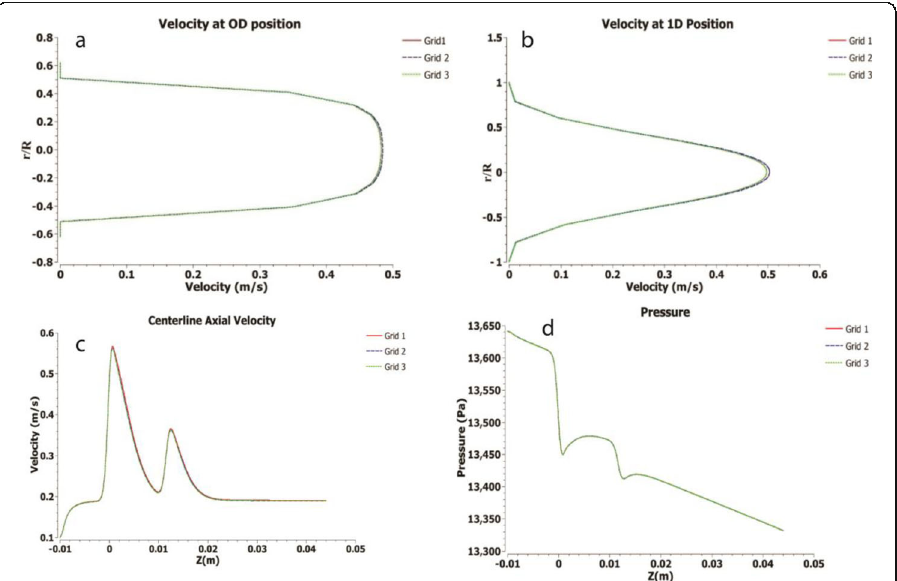
Fig. 2 Grid dependency test for the simulations. a velocity at 0D position, b velocity at 1D position, c centerline axial velocity, and d